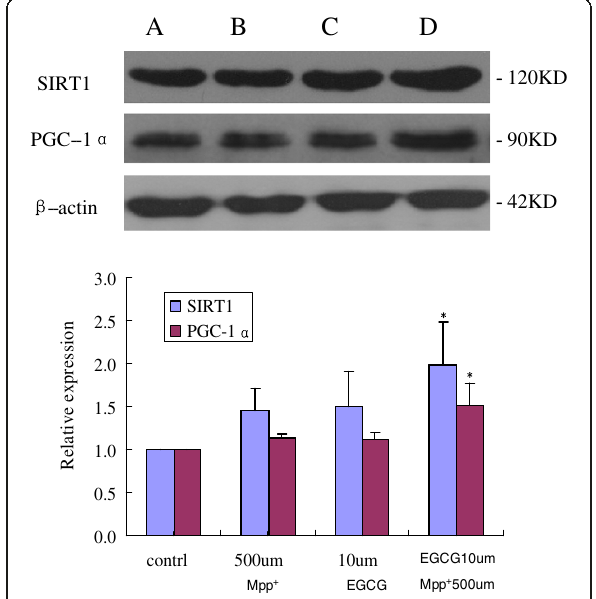
Figure 3 Effect of MPP + and EGCG on PGC-1 α and SIRT1 protein expression in PC12 cells. (A) vehicle-only control, (B) MPP + alone, MPP + 500 μ mol/L, (C) EGCG alone, 10 μ mol/L EGCG, (D) 10 μ mol/L EGCG+500 μ mol/L MPP + (treatment with EGCG for